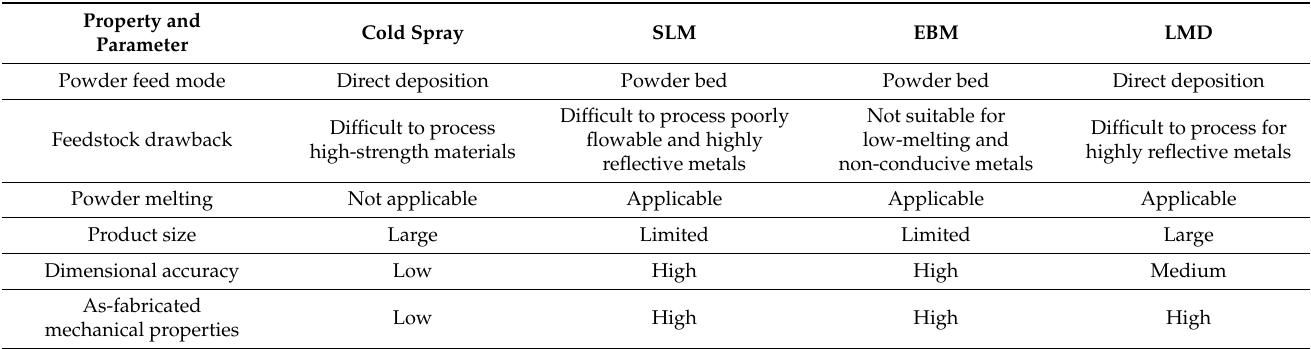
Table 1. Comparison of cold spray technology with three methods under powder-based additive manufacturing